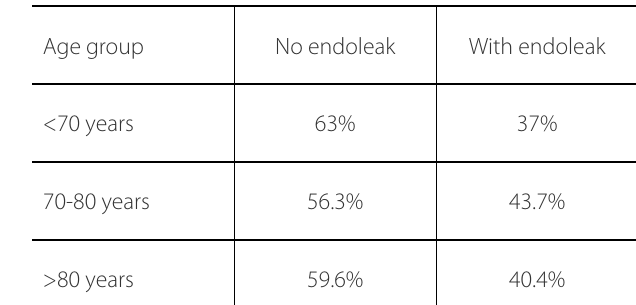
Table 4. Presence of endoleak by age